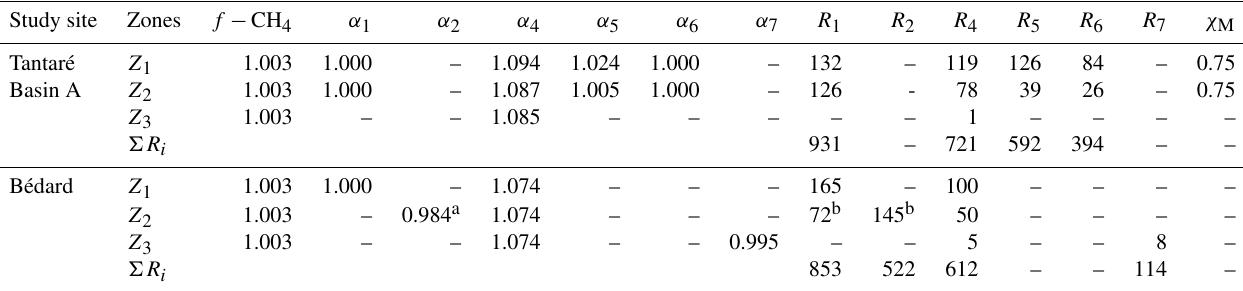
Table 3. Molecular diffusivity ratio of CH 4 ( f − CH 4 ) as well as the isotopic fractionation factors ( α 1 , α 2 , α 4 – α 7 ), the fraction of oxidant used by methanotrophy ( χ M ), and rates ( R 1 , R 2 , R 4 – R 7 ; fmolcm − 3 s − 1 ) of each reaction involved in OM mineralization in each zone and for the whole sediment column ( (cid:54)R i ; fmolcm − 2 s − 1 ) corresponding to the lowest values of N res . At both study sites, R 3 was shown to be negligible. See Sect. S2 of the Supplement for